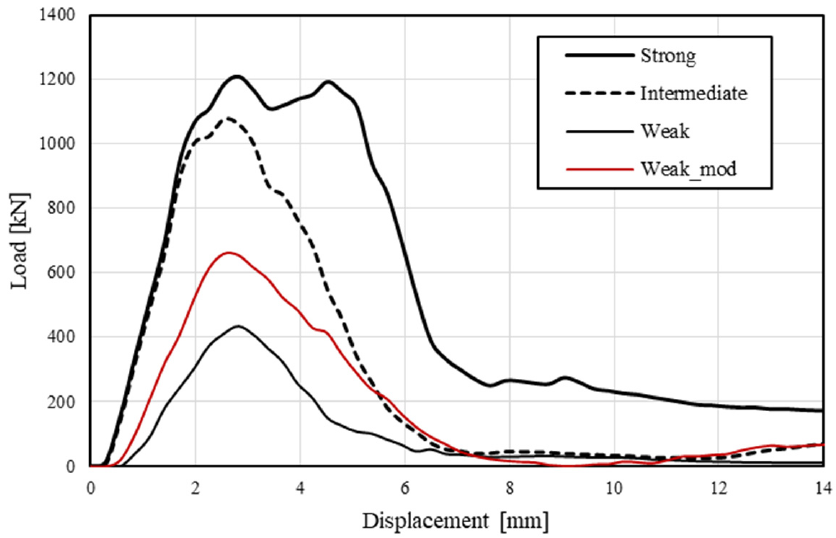
Figure 11. Load vs. displacement curves for different mortar grades. Table 4. Mechanical properties of mortars.